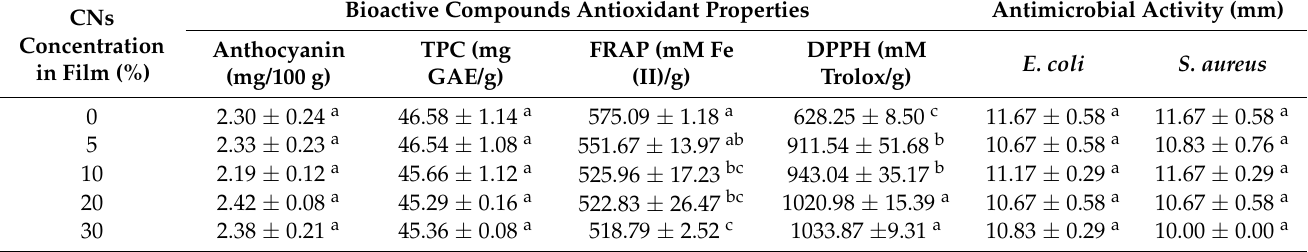
Table 6. Antioxidant and antimicrobial properties of smart bilayer films incorporating different concentrations of cellulose nanosphere